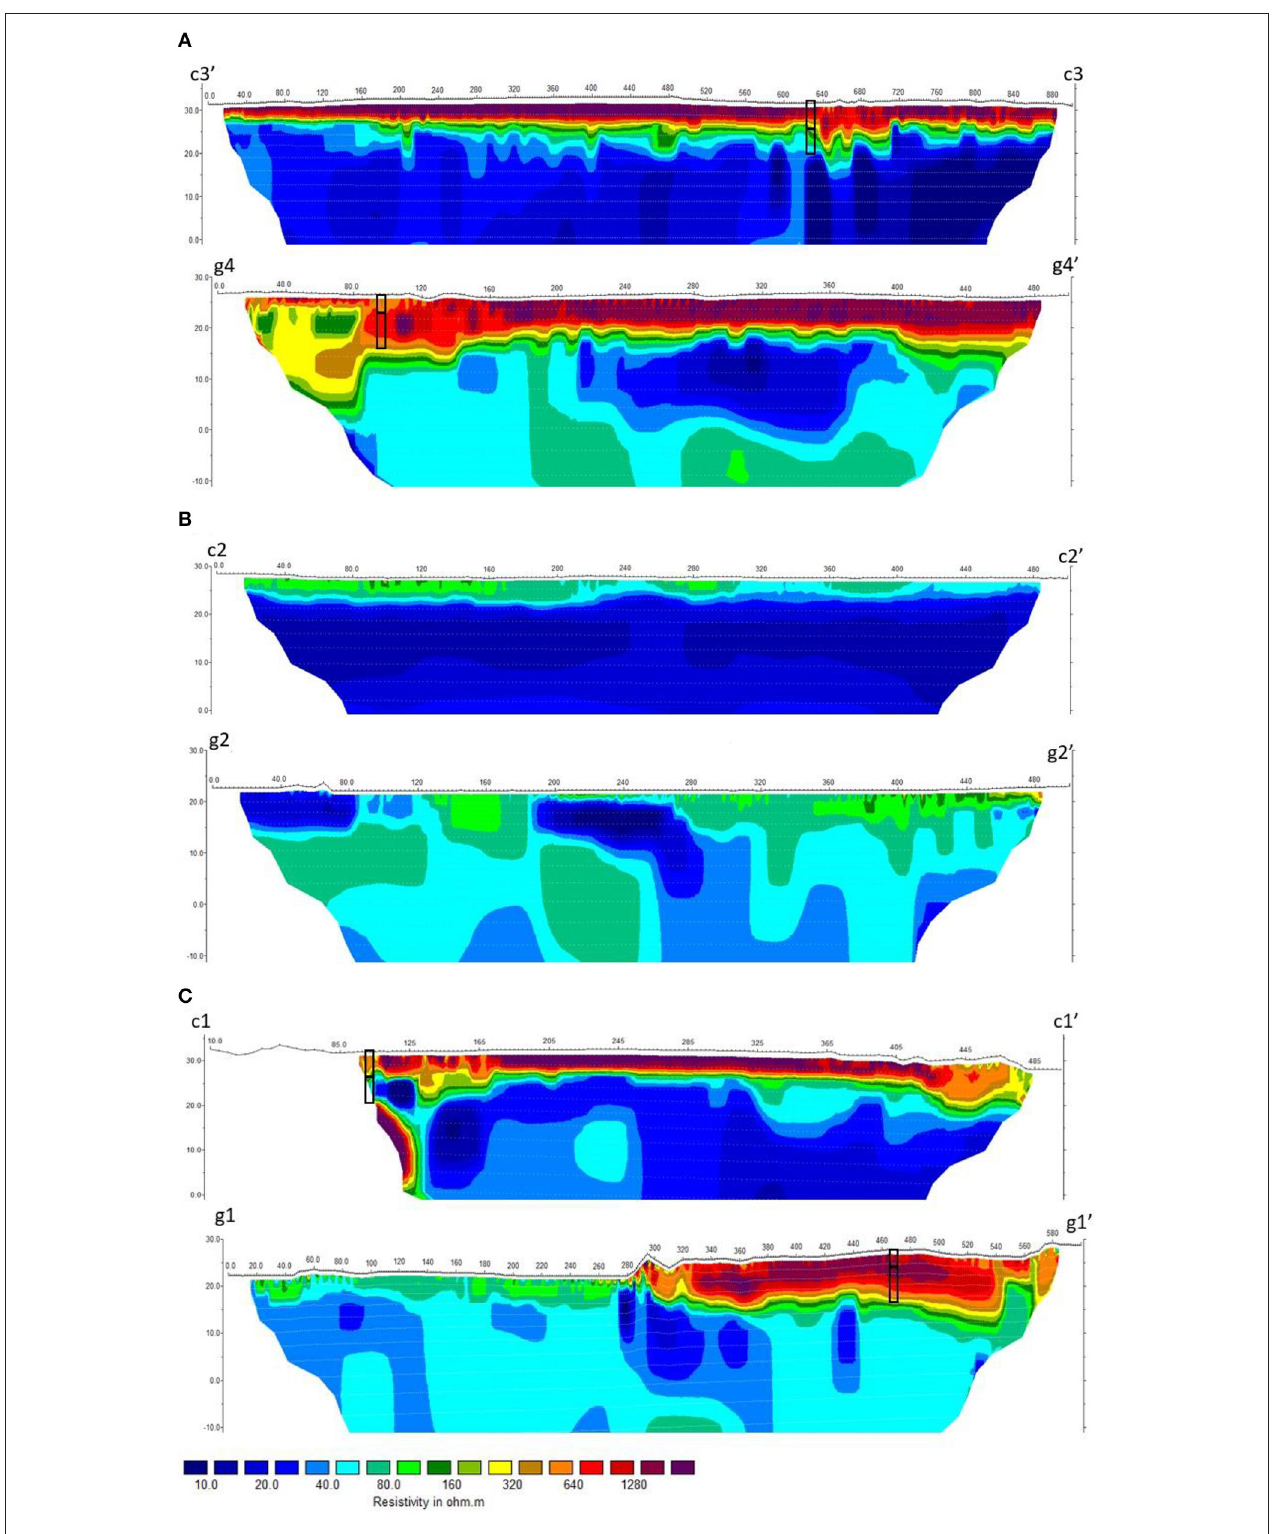
FIGURE 5 | 2D ERT profiles combined with topography taken at Chókwè and Guijá sites (for the location see Figure 4 ); (A) longitudinal profile of the sand dunes; (B) longitudinal profile of the river valley; and (C) transverse profile. The boreholes presented in the cross-sections are 10m deep and the level of the water table is provided as a black bar in the middle of the